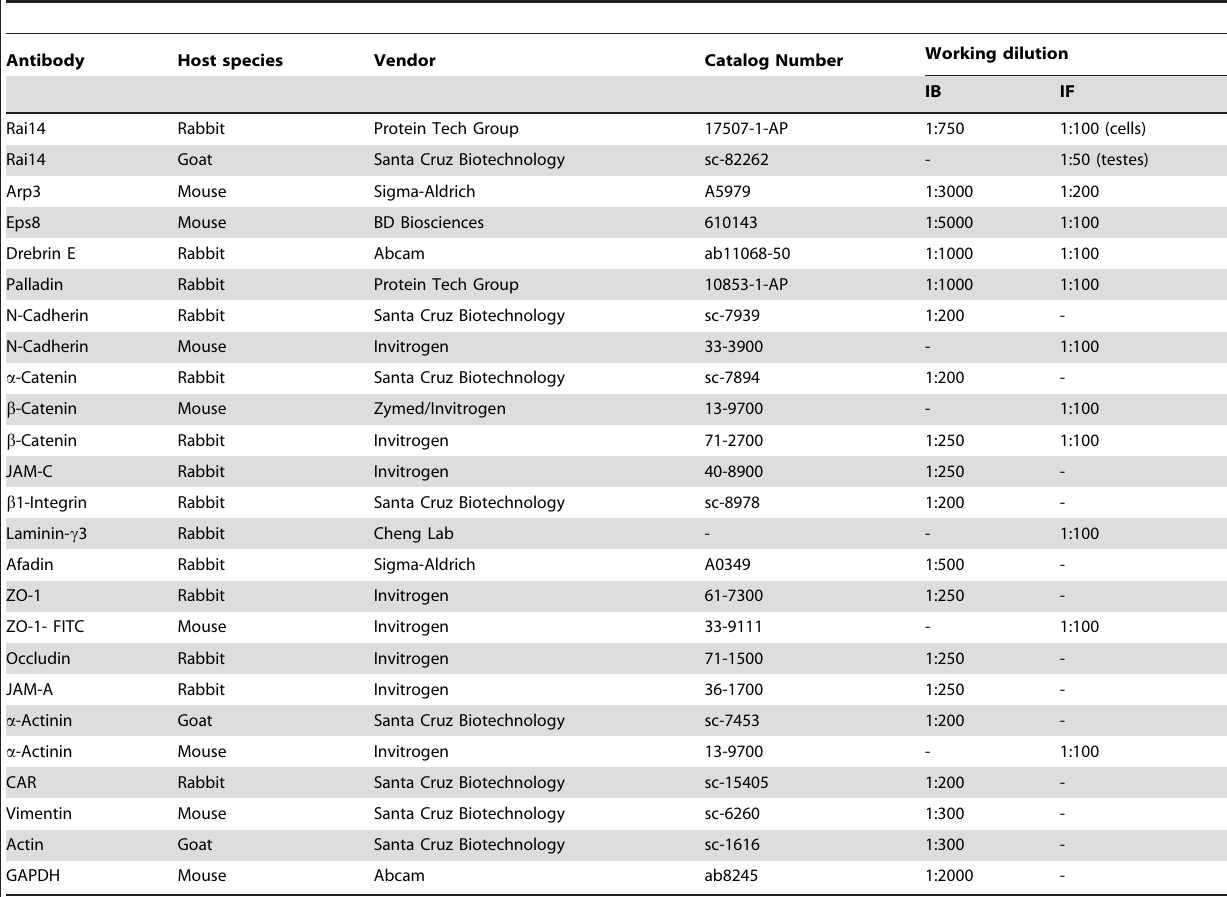
Table 1. Antibodies used for different experiments in this report*.